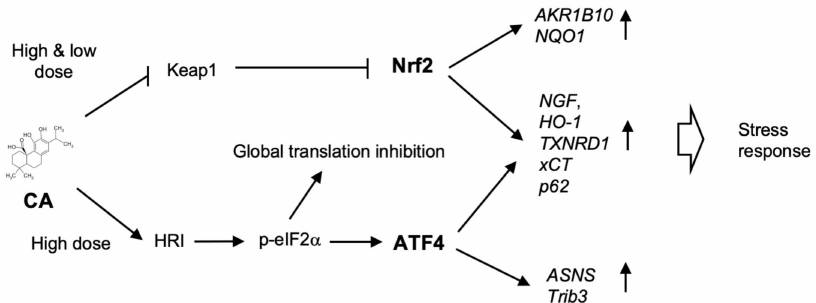
Figure 7. Hypothetical scheme of CA action in mammalian cells. CA activates the Nrf2 pathway only at a low dose ( ≤ 20 µ M) but activates both Nrf2 and ATF4 pathways at a high-dose ( ≥ 50 µ M). Induced Nrf2 and ATF4 independently and cooperatively up-regulate CA-inducible gene expression (arrows pointing up) to exhibit physiological effects, such as stress response (bold white arrow). The arrows indicate activation and T-arrows show